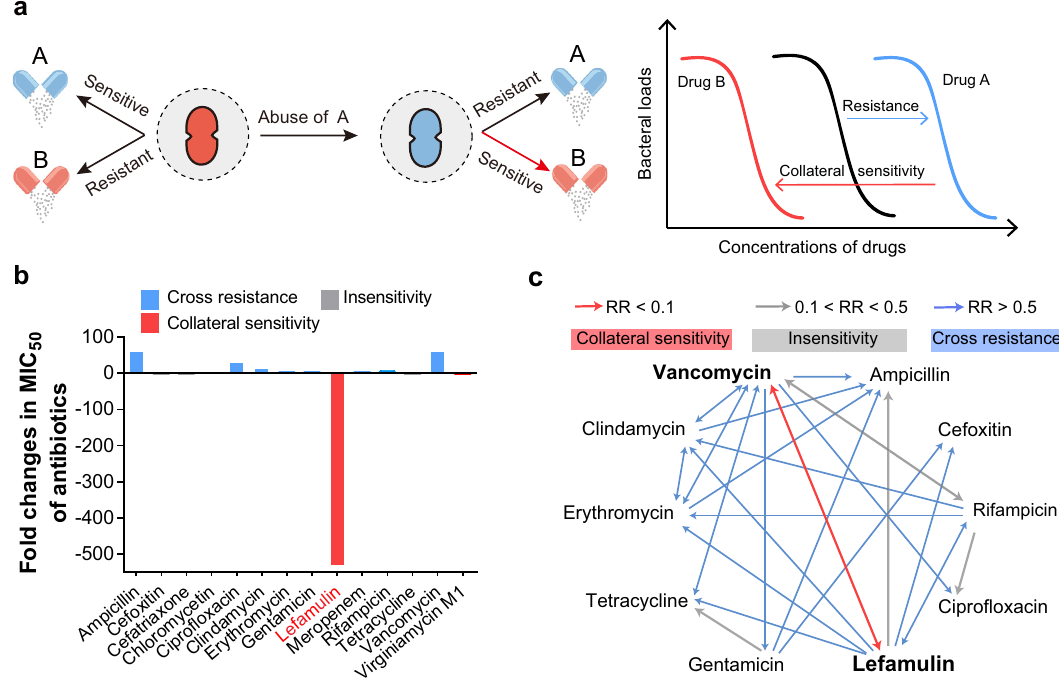
Fig. 1 Vancomycin-resistant E. faecium show collateral sensitivity to lefamulin. a Scheme of collateral sensitivity. Bacterial evolution of resistance to one antibiotic is usually accompanied by collateral sensitivity to another antibiotic. b Fold changes in MIC 50 of 14 antibiotics between VRE fm ( n = 20) and VSE fm ( n = 20). c Collateral sensitivity network among antibiotics in E. faeicums . For collateral sensitivity network, the directed paths of each arrow represent the collateral sensitivity (red), cross resistance (blue) and insensitivity (gray). Resistance ratio (RR) = MIC 50 (resistance)/MIC 50 (parental). Collateral sensitivity (CS): RR < 0.1, insensitivity: 0.1 < RR < 0.5, cross resistance (CR): RR >